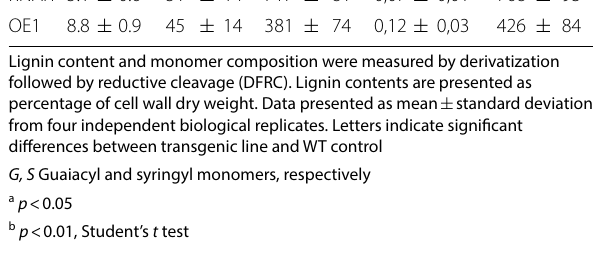
Table 1 Lignin content and monomer composition in WT and CWPO‑C transgenic poplar Lignin (%) µmol S/g